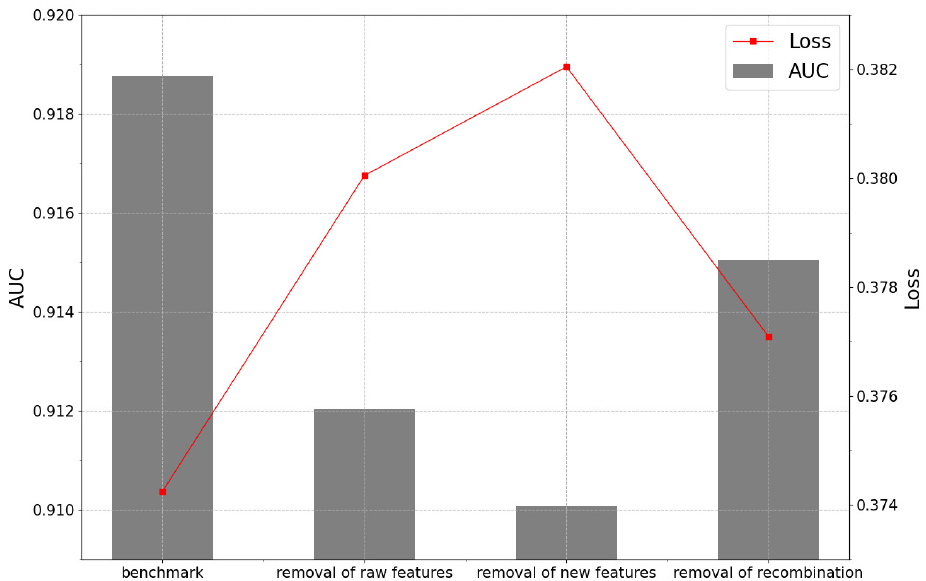
Figure 10. The impact of different parts of the feature-generation module on model